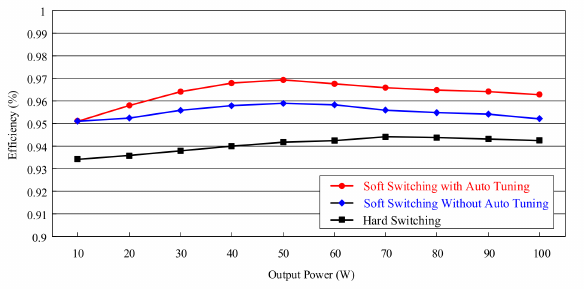
Figure 20. Efficiency